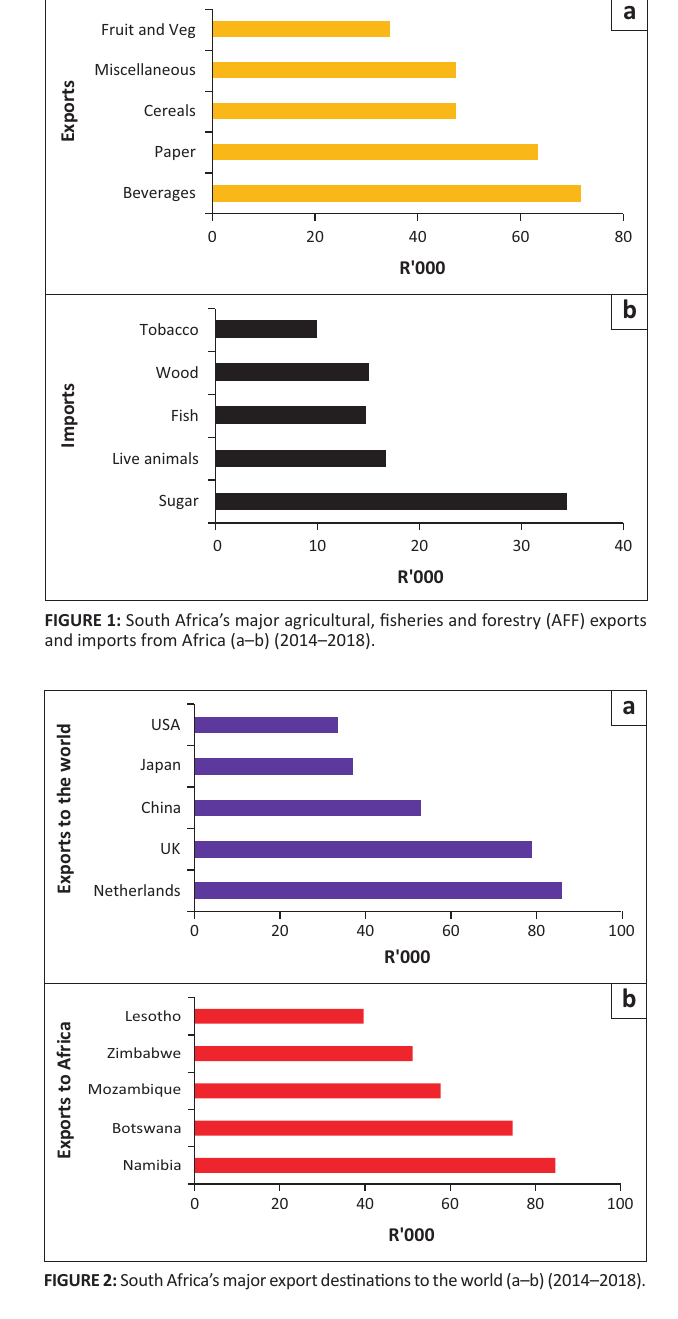
FIGURE 2: South Africa’s major export destinations to the world (a–b) (2014–2018).